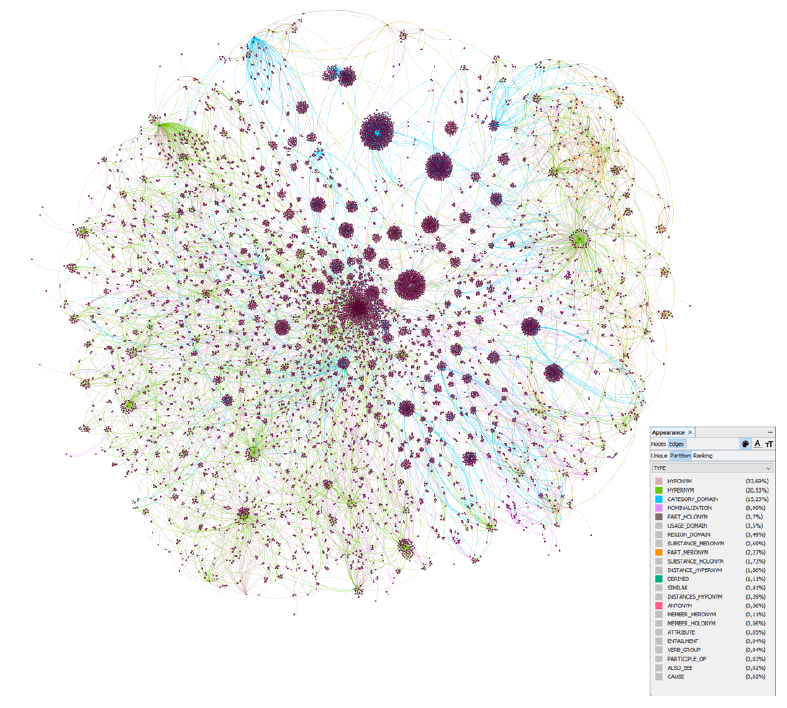
Figure 9. Knowledge Base.